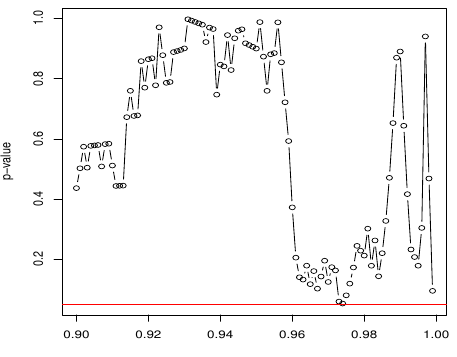
Figure 6. Kupiec’s p -values for the best fitting distributions for daily log returns of the exchange rates of Bitcoin (first row, left), Dash (first row, right), Dogecoin (second row, left), Litecoin (second row, right), MaidSafeCoin (third row, left), Monero (third row, right) and Ripple (last row) from 23 June 2014 until 28 February 2017.